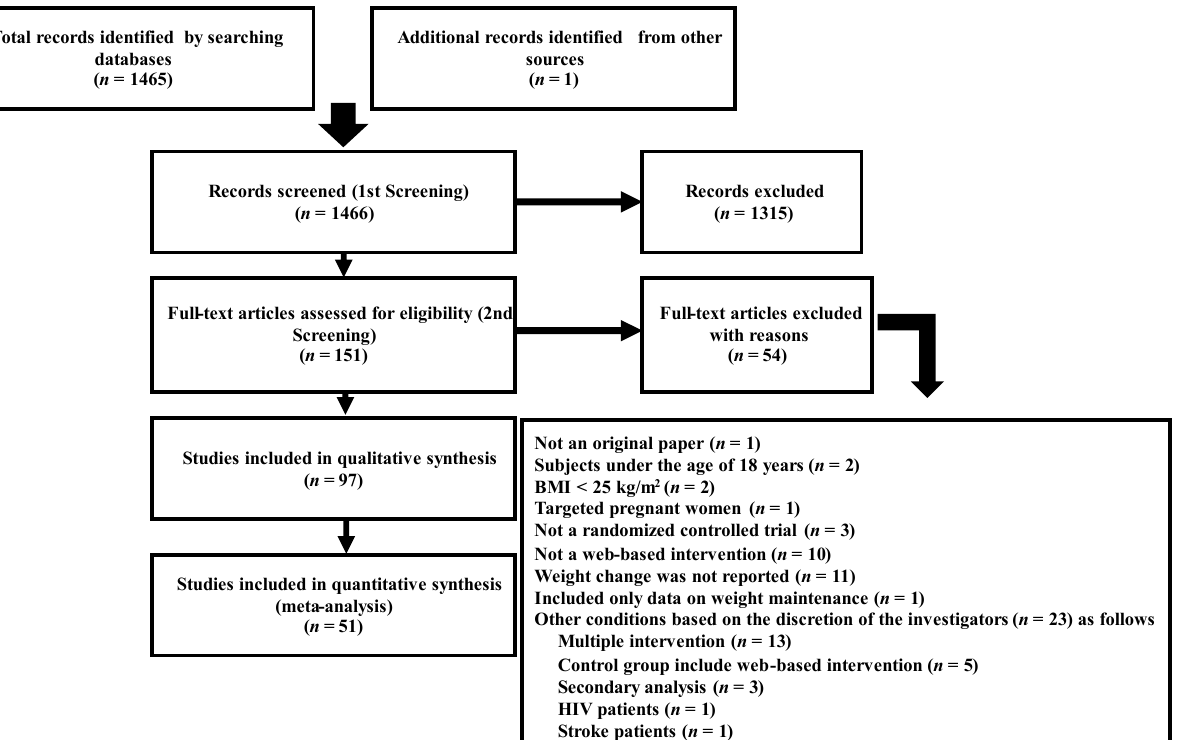
Figure 1. A flowchart illustrating the Preferred Reporting Items for Systematic Reviews and Meta-Analyses.